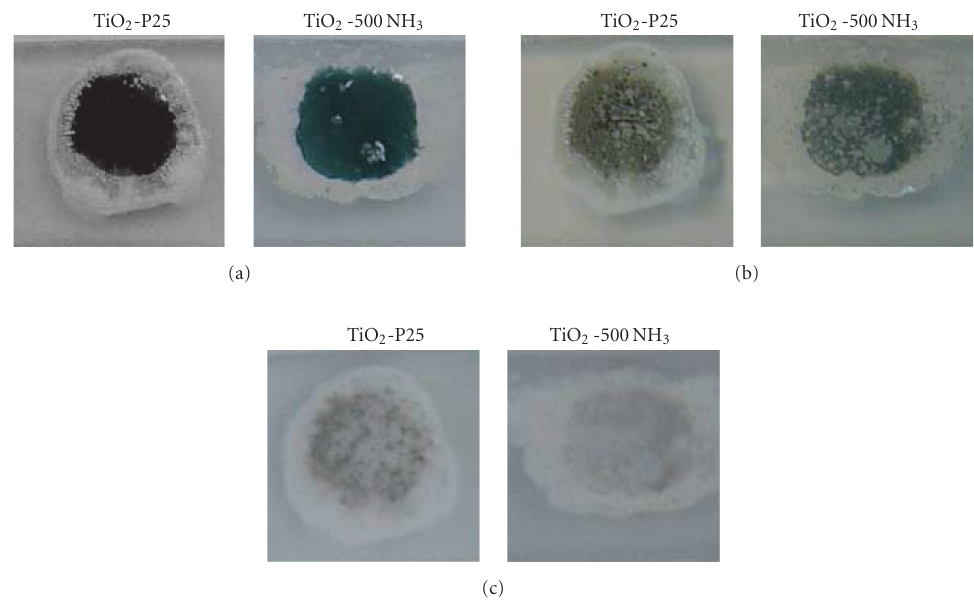
Figure 7: The photos of TiO 2 -P25 and TiO 2 /N 500 placed on glass plate after sandblasting with adsorbed Direct Green 99 in time of visible light irradiation (a) after drop of azo dye, (b) after 24 hours of irradiation, and (c) after 120 hours of